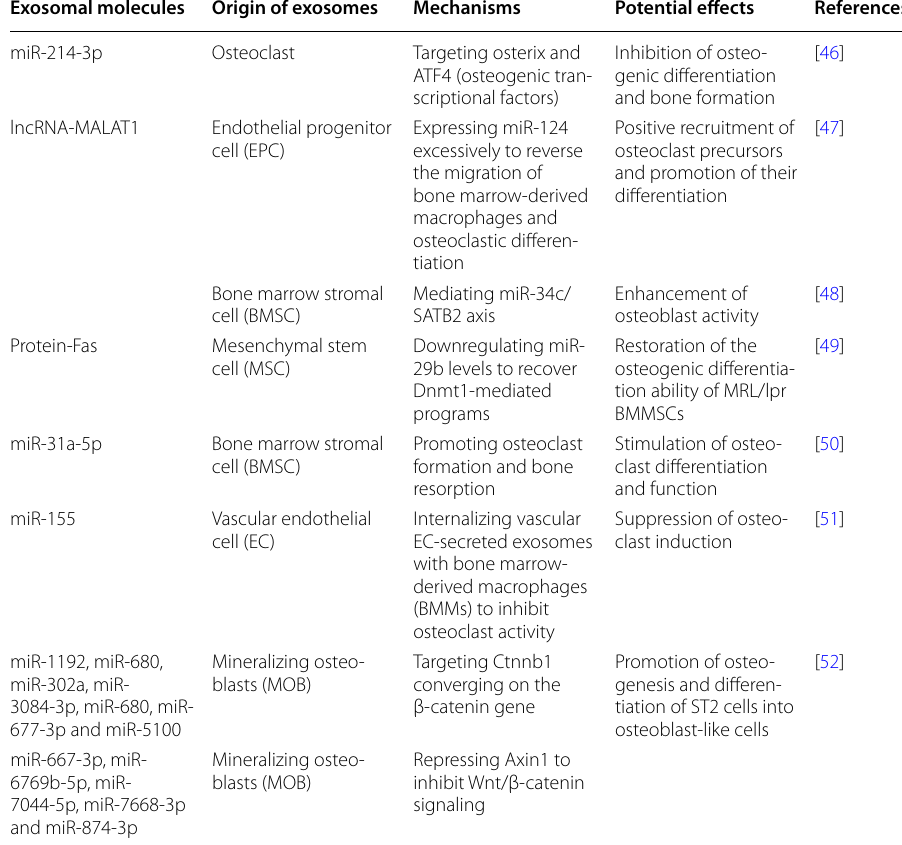
Table 3 Potential effects of exosome molecules on bone metabolism Exosomal